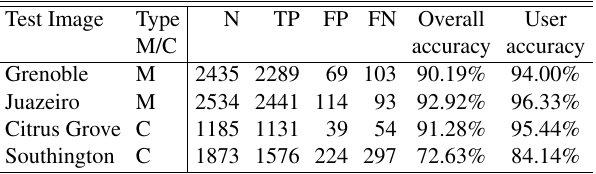
Table 2: Results of the tree counting algorithm for the four test images (France, Brazil, two in the USA). Legend: Type M=monochromatic, Type C=color N=number of trees, TP=true positive, FP= false positive, FN=false negative. User accuracy is the success rate attained when considering only the trees within the orchard’s limits (no comission error).